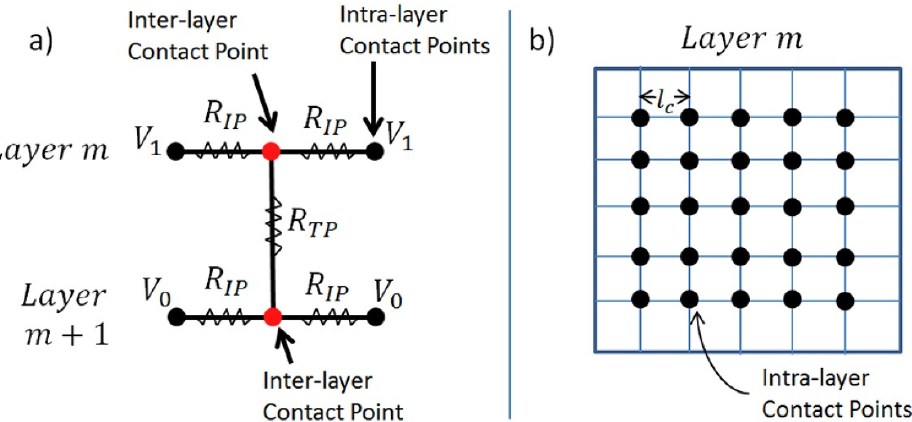
Figure 9. Resistor network of a nanofiber mat: ( a ) conductivity between layers; ( b ) formation of contact points inside a single layer. Reprinted from [243], with permission from Elsevier.